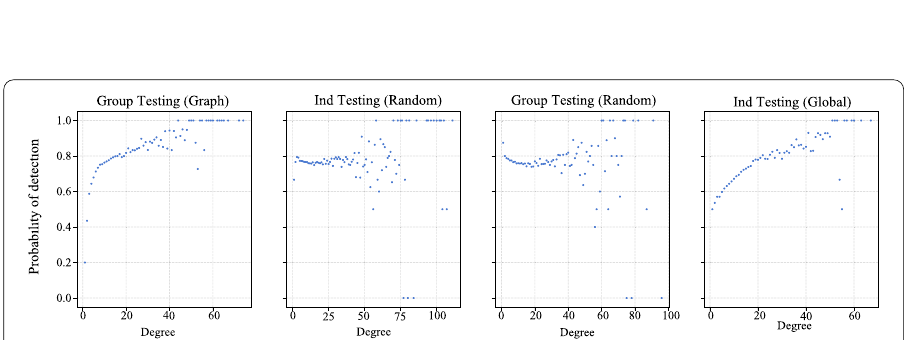
Fig. 7 The probability that an infected node is detected as a function of its